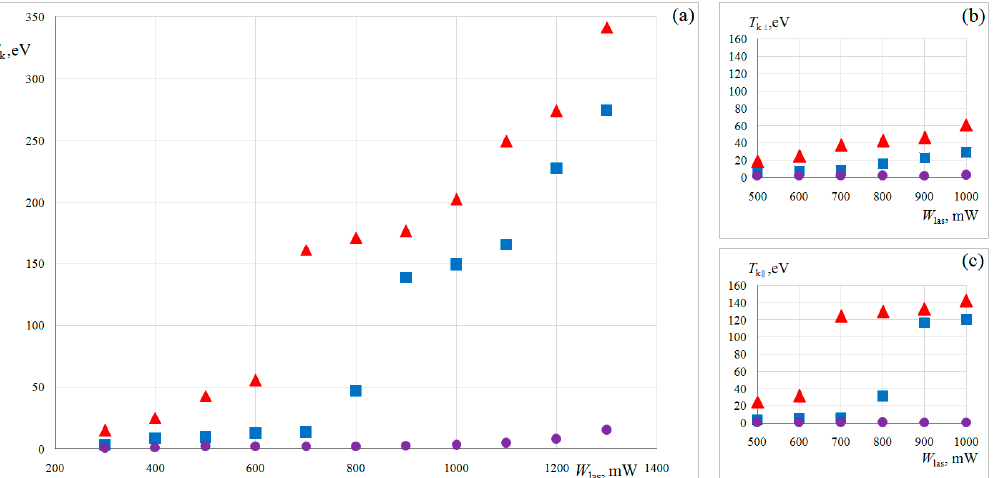
Figure 5. ( a ) Dependence of the mean kinetic energy of single dust particles on the laser power W las ; ( b ) the same, but for the longitudinal (axial) component of the active Brownian motion; ( c ) the same, but for the transverse (radial) component of the active Brownian motion. Uncoated dust particle (circles); Cu-coated dust particle (squares); Janus particle (triangles).